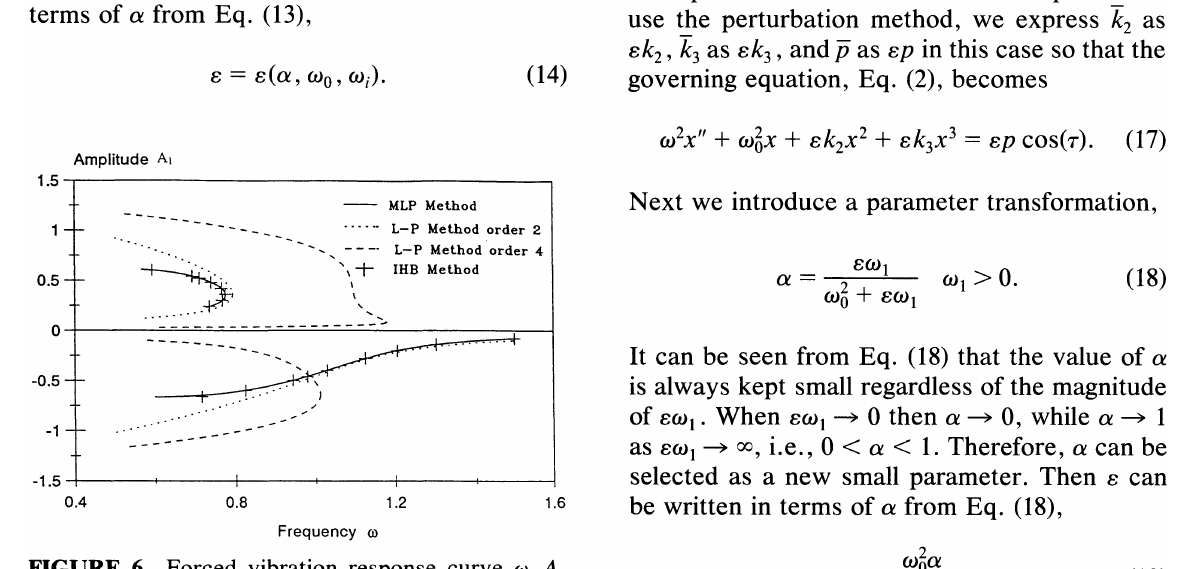
FIGURE 6 Forced vibration response curve w-A I for e = 1, Wo = 1, k2 = 1.2, k3 = 0.2, and p =